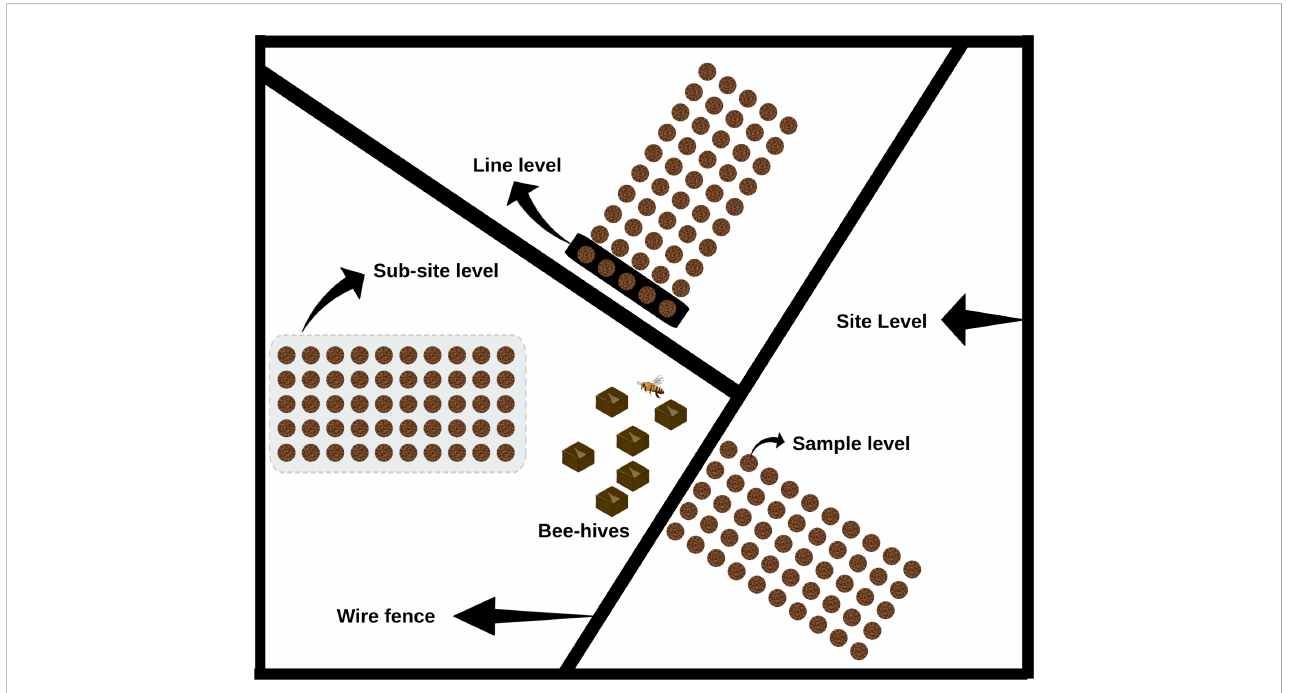
FIGURE 2 Schematics of hosts and parasitoid sampling showing the different scales considered in the